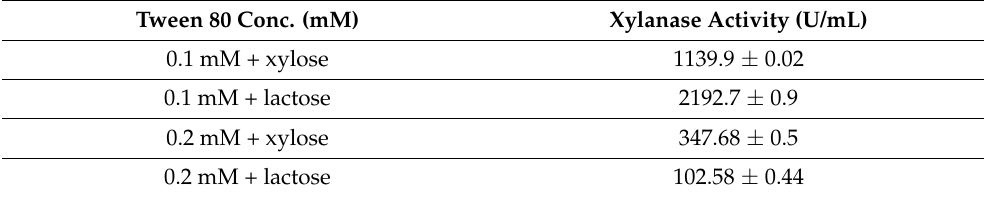
Table 1. Relation of Tween 80 concentrations to xylanase production by Trichoderma harzianum